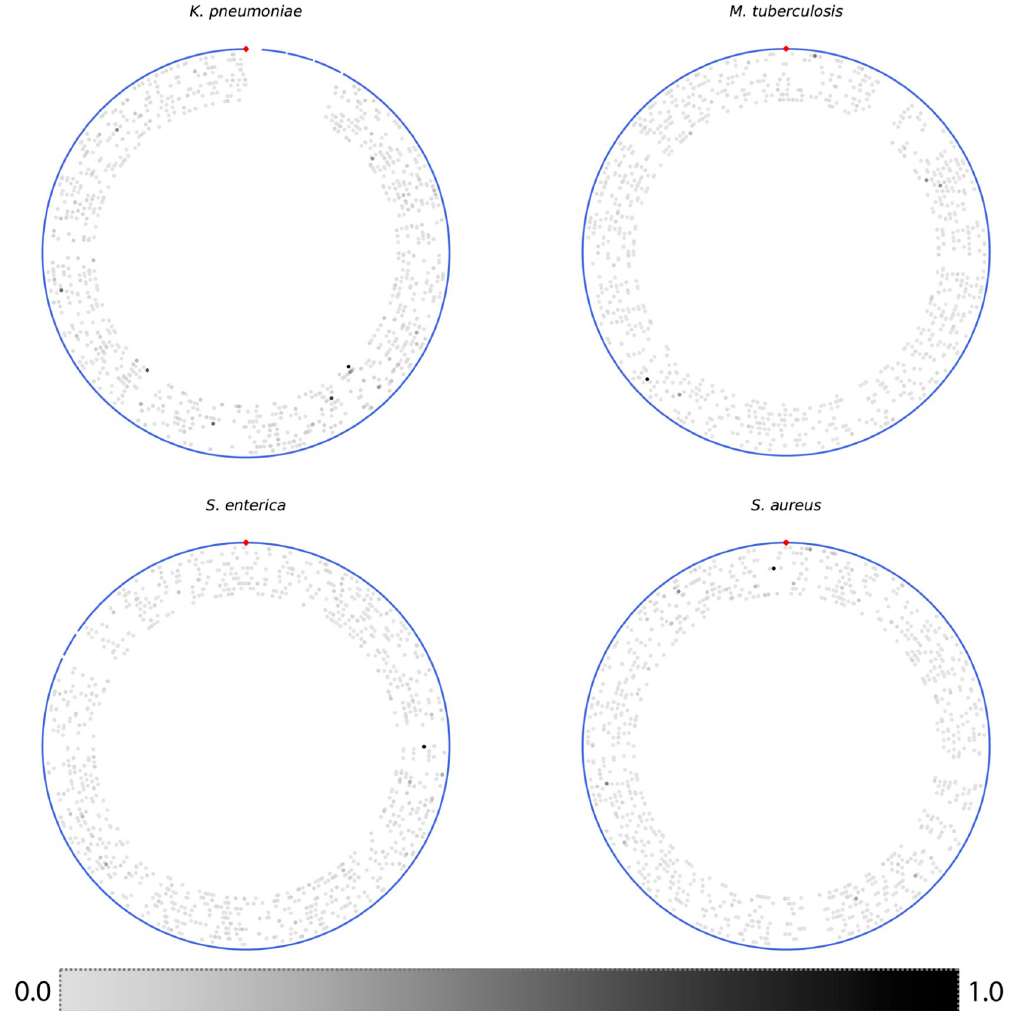
Fig 8. Plots showing the position and total feature importance of each core gene based on its coordinates in a reference genome. The contigs from the reference genome are depicted as blue lines on the outside of each plot, and the origin of replication is shown at the top with a red diamond. Each gene is depicted as a gray dot, and the genes with higher total feature importance in each model are colored in darker shades of gray. The genes of each model are shown as concentric circles from outside to inside. The reference strains used were K . pneumoniae HS11286, M . tuberculosis H37Rv, S . enterica serovar Typhimurium LT2, and S . aureus NCTC